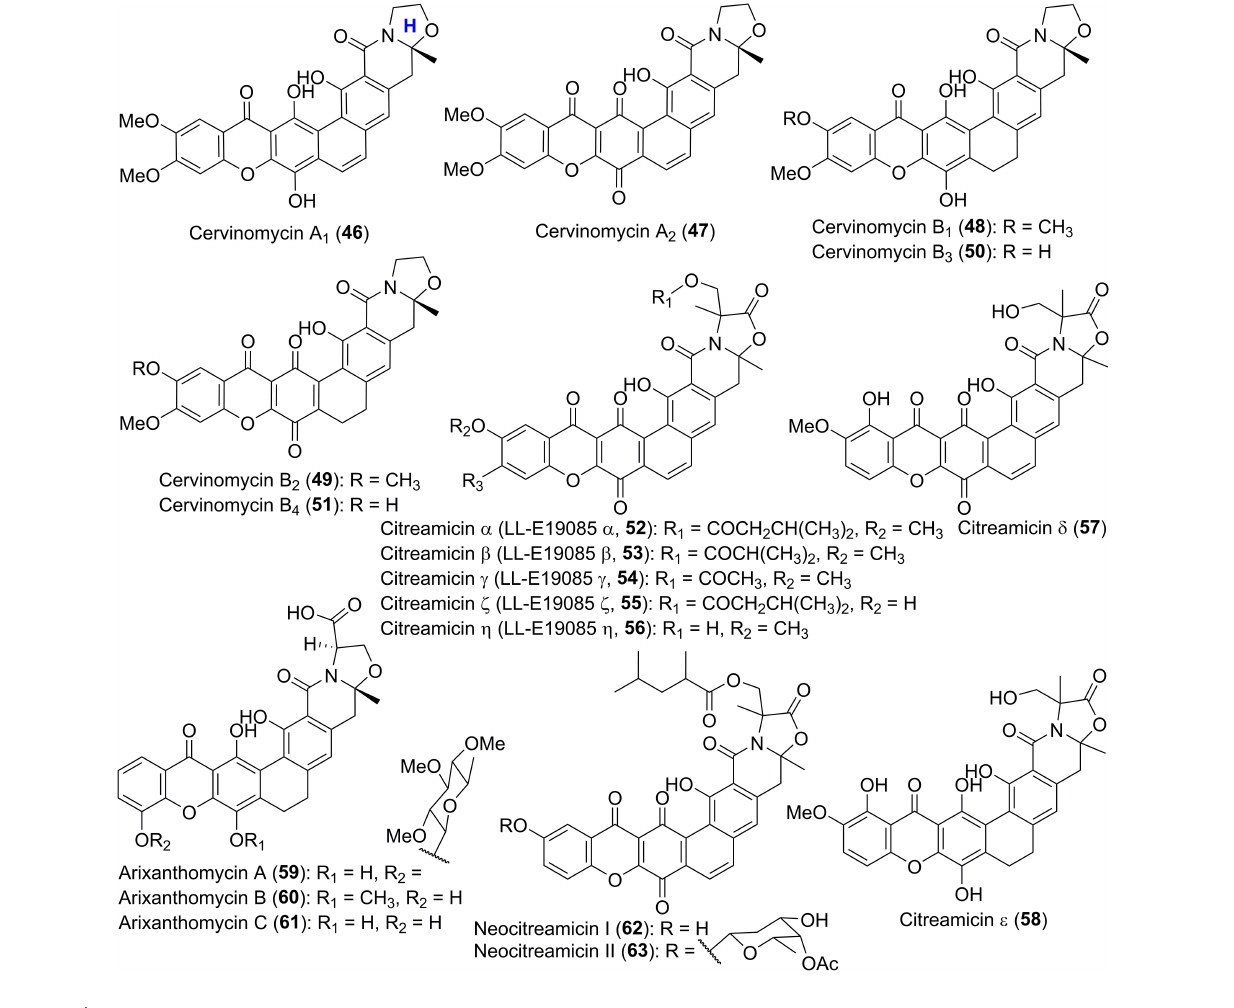
FIGURE 5 | Chemical structures of compounds 46–63